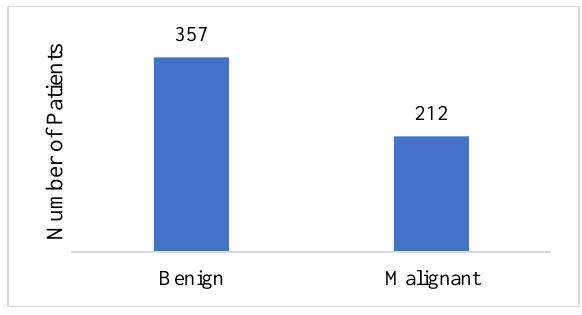
Fig. 1. Distribution of benign and malignant